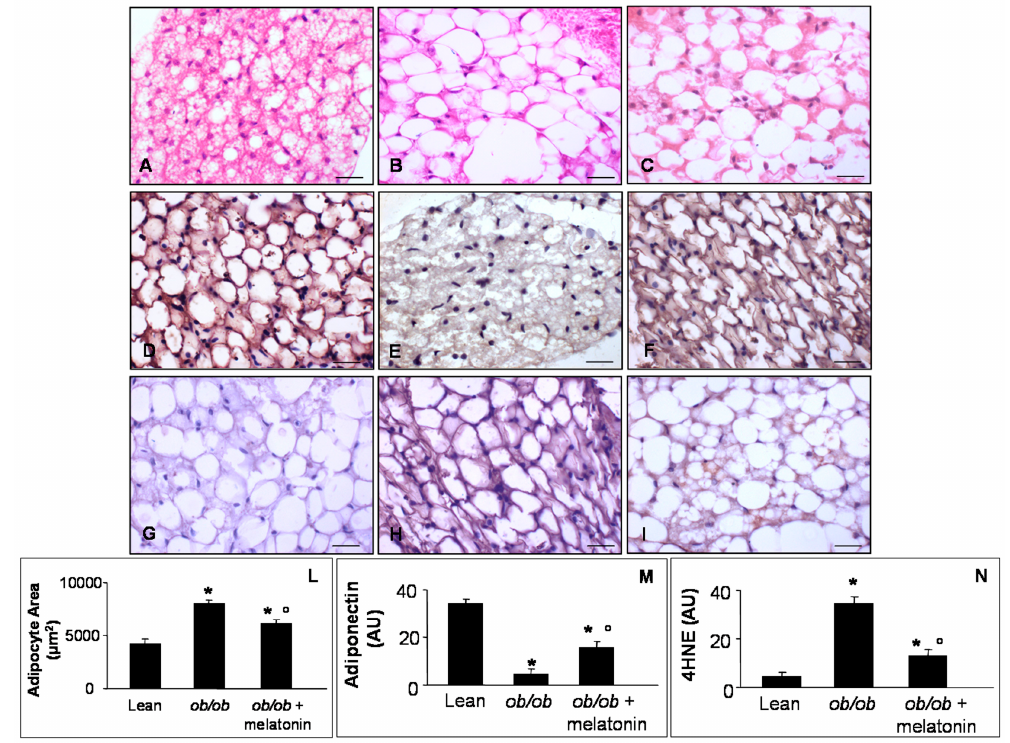
Figure 6. Pericardial adipose tissue evaluations. Photomicrographs showing pericardial adipocytes morphological feature through haematoxylin-eosin staining ( A – C ), anti-obesogenic adiponectin ( D – F ) and 4HNE ( G – I ) immunostainings of lean mice treated and not treated with melatonin ( A , D , G ), ob / ob mice ( B , E , H ) and ob / ob mice treated with melatonin ( C , F , I ). The graphs summarize adipocyte area ( L ), adiponectin ( M ) and 4HNE ( N ) immunopositivities. Lean mice treated or not with melatonin displayed similar “normal” pericardial adipose tissue features, so they are defined generically as “lean” mice. Note that ob / ob mice treated with melatonin showed a reduced white adipocytes area and inverse relationship between anti-diabetogenic adiponectin and 4HNE. Scale Bar = 20 µm. * p ≤ 0.05 significant vs. lean mice; ° p ≤ 0.05 significant vs. ob / ob mice.